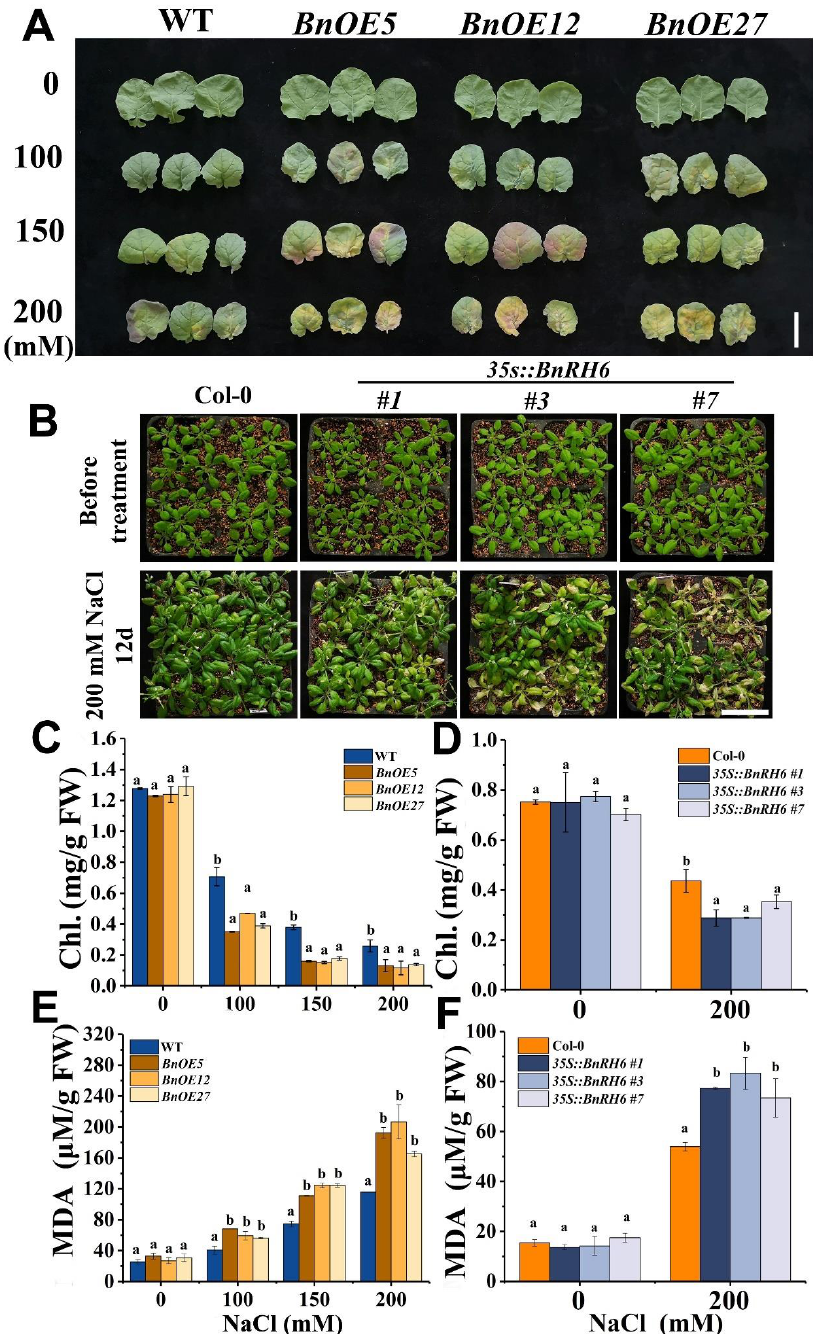
Figure 4. Effects of NaCl on the concentrations of chlorophyll and MDA in the transgenic BnRH6- overexpression Brassica ( BnOE s) and Arabidopsis (35S:BnRH6s or AtOE ). For Brassica , 10-day-old BnOE and wild-type plants were hydroponically grown and treated with NaCl at 0 to 100, 150, and 200 mM for 14 days. Regarding Arabidopsis , plants were potted in soil in conditioned cham- bers. Three-week-old AtOE and wild-type plants were treated with NaCl at 0 to 75, 100, 150, and 200 mM for 14 days. ( A ): Phenotypes of Brassica leaves under salinity stress. ( B ): Phenotypes of AtOE plants following treatment with 200 mM NaCl for 12 days. ( C ): Chlorophyll concentrations in BnOE plants. ( D ): Chlorophyll concentrations in AtOE plants. ( E ): MDA concentrations in BnOE plants. ( F ): Chlorophyll concentrations in AtOE plants. Chl: Chlorophyll. MDA: malondialdehyde. FW: fresh weight. Vertical bars represent mean values ± SD (n = 30). Different letters indicate significant differences between three independent experiments (analysis of variance; p < 0.05). Sacle bar = 3